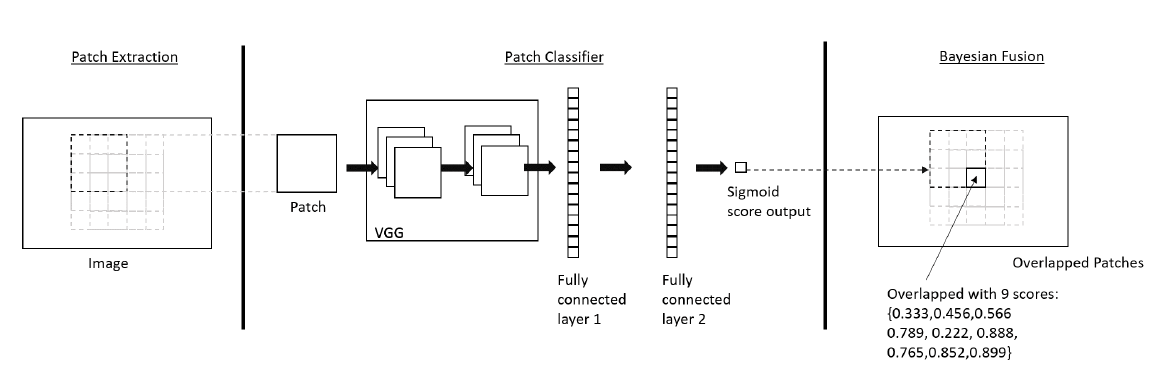
Figure 3. The architecture of the proposed defect detection approach.